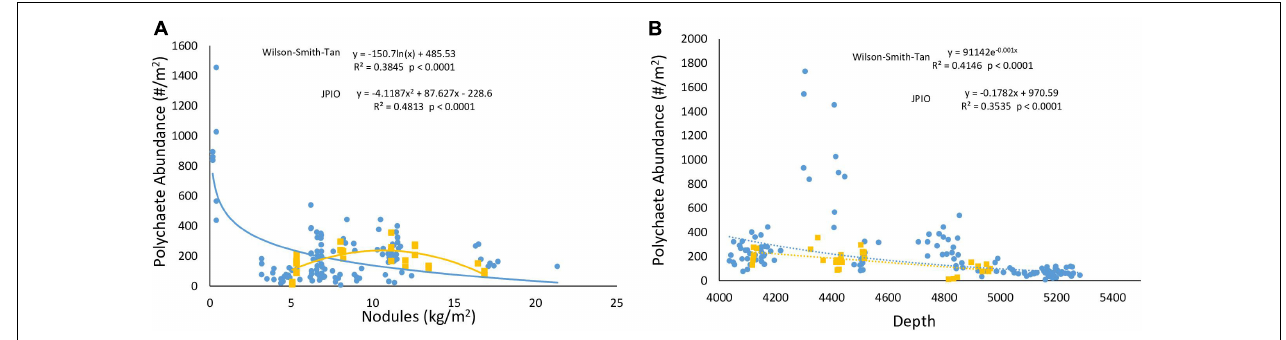
FIGURE 3 | (A) Nodule abundance and (B) depth versus polychaete abundance in the Wilson–Smith – Tan (blue) and JPIO (yellow) data sets. Lines shown are Type II regressions conducted in R. All regressions are highly statistically significant ( p < 0.0001).